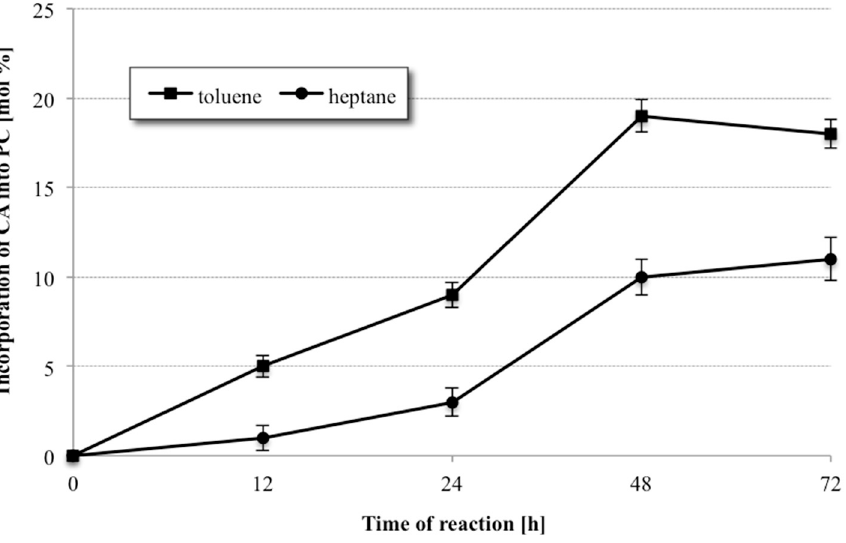
Figure 3. Effect of different organic solvent on the incorporation of CA into egg-yolk PC in acidolysis reaction (reaction conditions: 1:30 PC/CA molar ratio, enzyme load 20% ( w / w ) Novozym 435, solvent toluene/heptane 2 mL, temperature 30 °C).